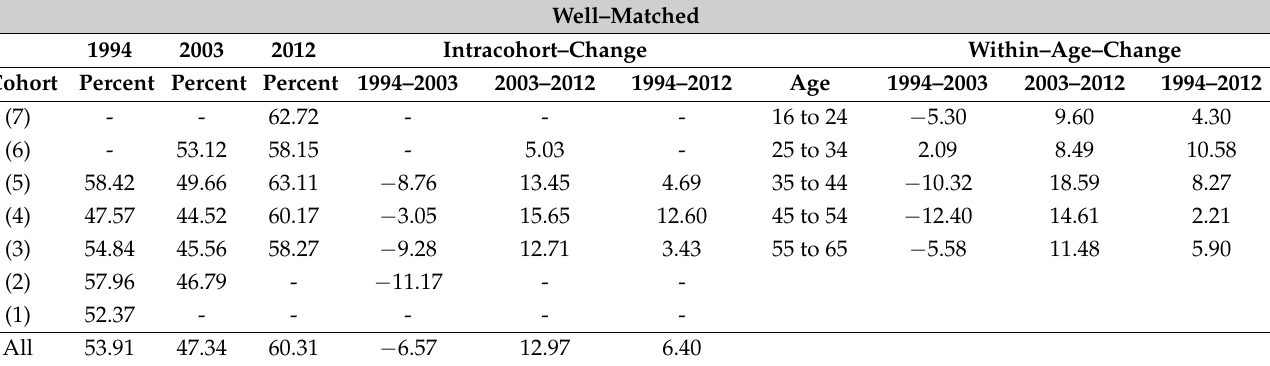
Table A3. The incidence and change of educational